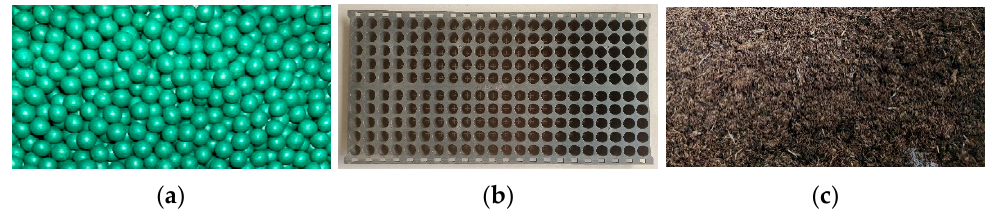
Figure 24. Experimental materials: ( a ) Coated seeds; ( b ) Tray; ( c ) Soil matrix.